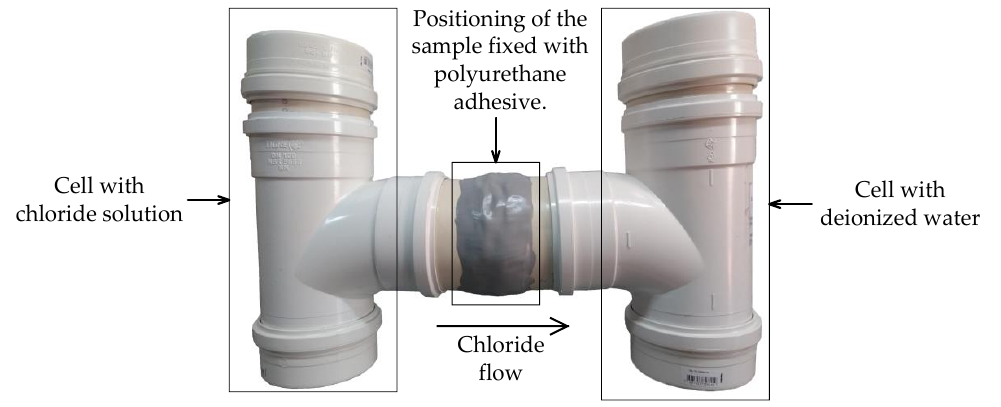
Figure 5. Chloride diffusion testing apparatus.